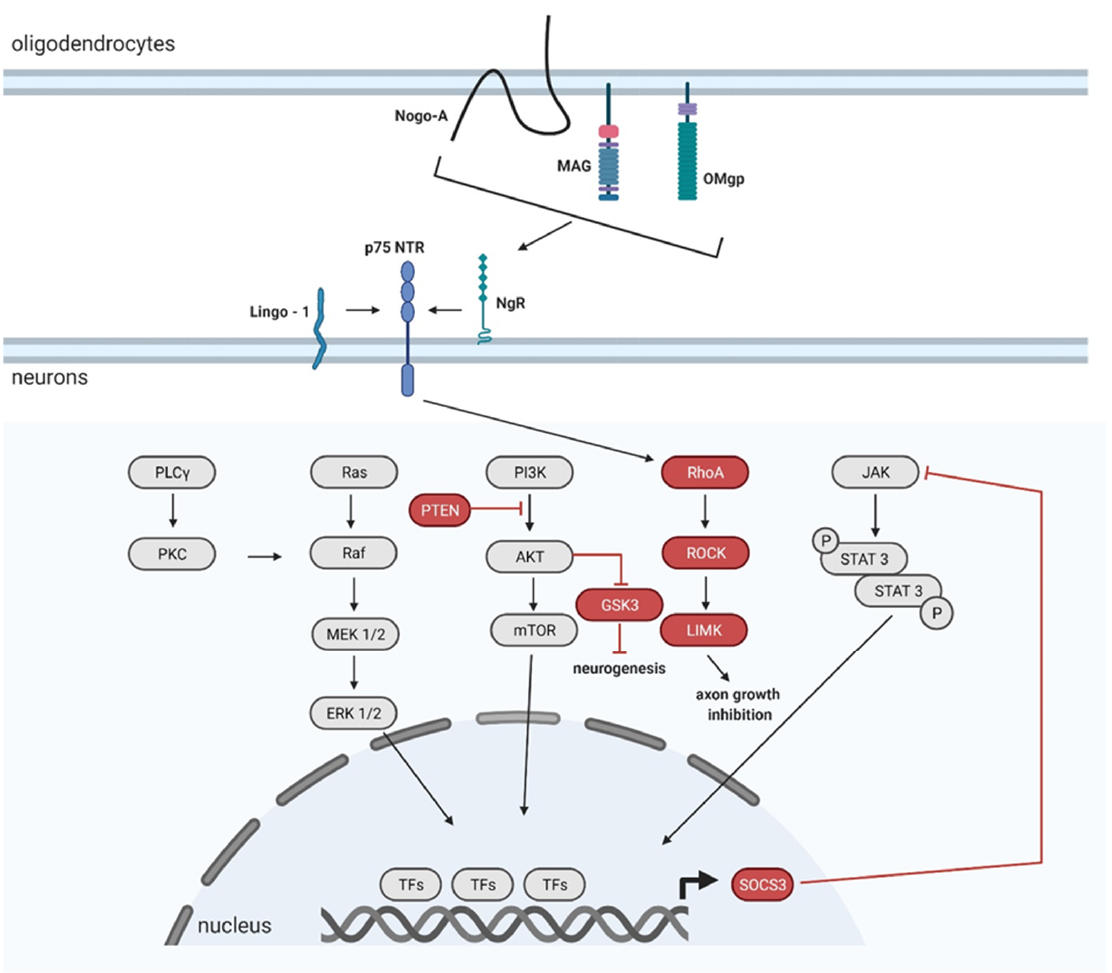
Figure 5. Schematic representation of experimentally inactivated targets mentioned in the text above. Inhibitors and TFs due to which CNS effort to regenerate fails are marked in red (Created with BioRender.com).